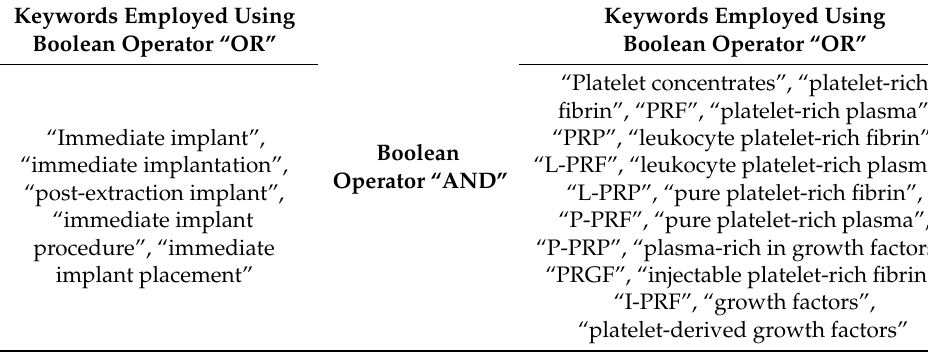
Table 1. Search strategy employed in the present systematic